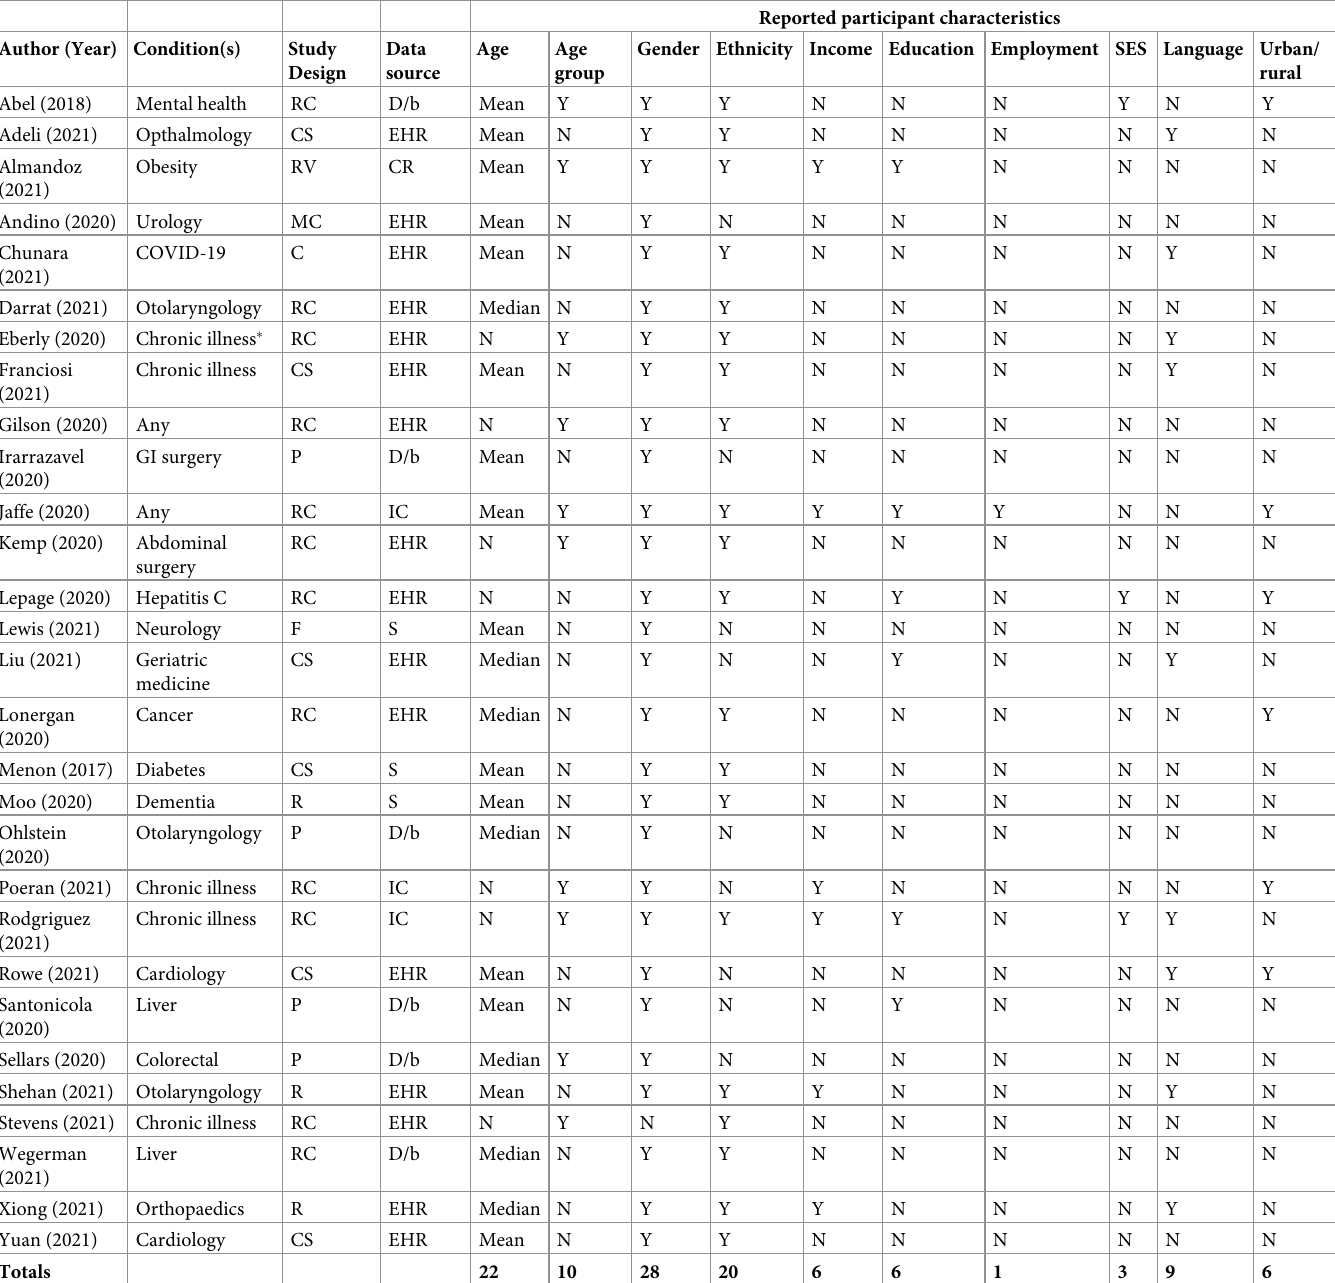
Table 2. Summary of included